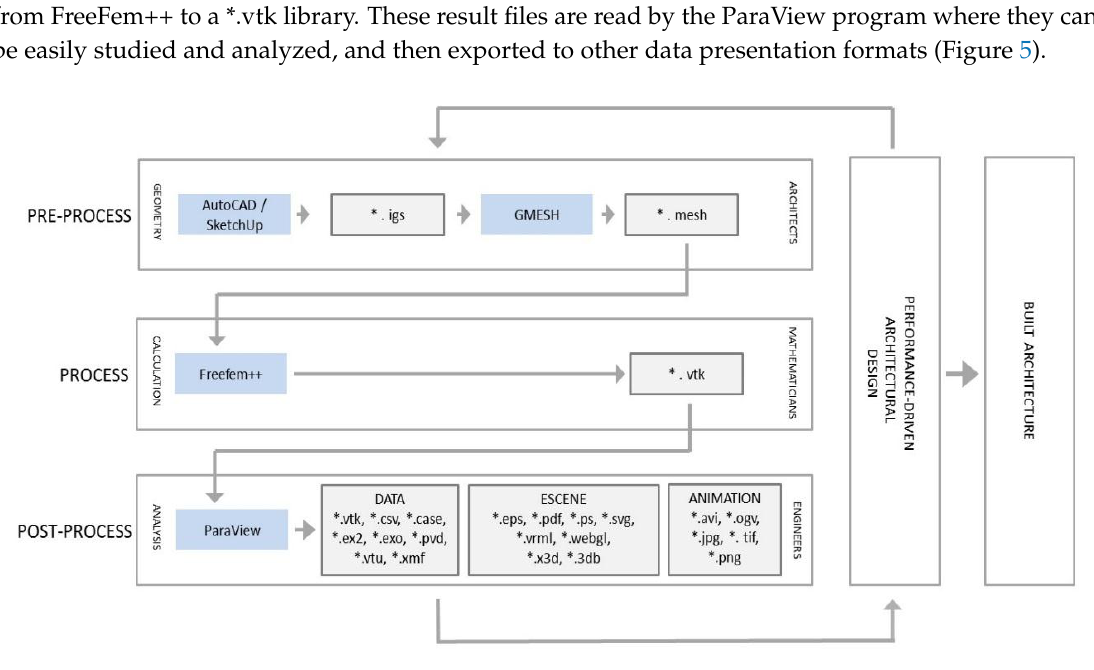
Figure 5. Diagram of the proposed plug-in method.